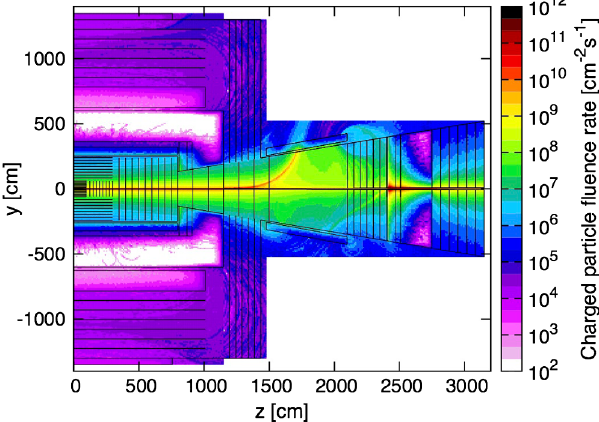
FIG. 6. Charged particle fluence rate for an instantaneous luminosity of 30 × 10 34 cm − 2 s − 1 : lateral view. In the central region ( z < 10 . 5 m) values are azimuthally averaged over 20 de- grees around π (positive y ) and − π (negative y ). In the forward 2 2 region an average in the horizontal direction around x ¼ 0 is done on a bin of 1 cm up to j y j ¼ 0 . 6 m and on a 10 cm bin for larger j y j values.